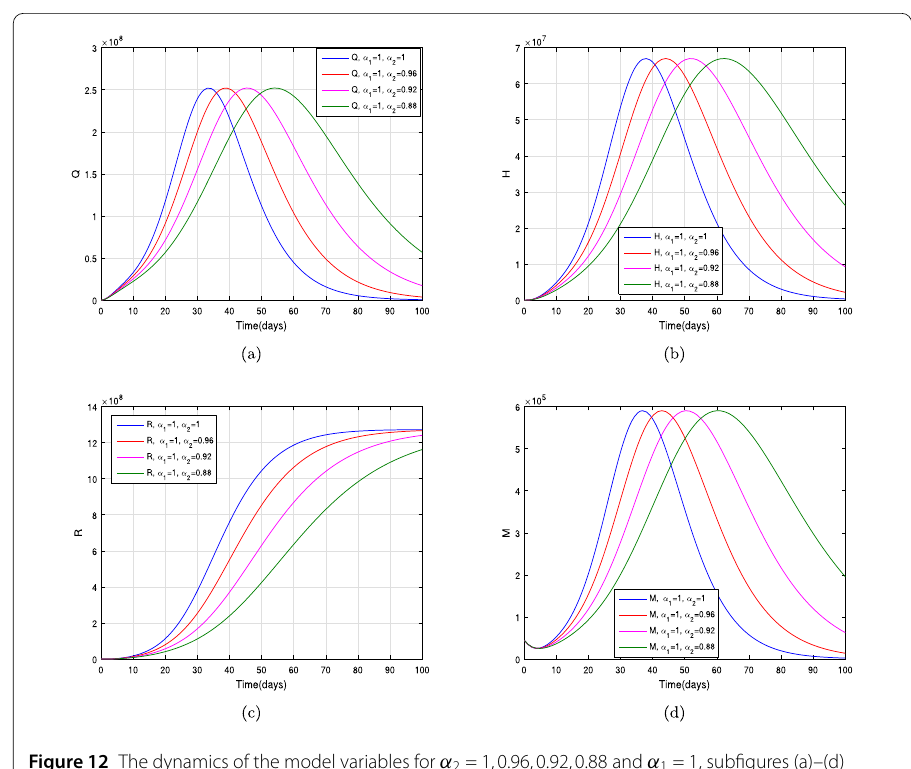
Figure 12 The dynamics of the model variables for α 2 = 1,0.96,0.92,0.88 and α 1 = 1, subfigures (a)–(d) respectively represent the quarantined, hospitalized, recovered, and contaminated environment